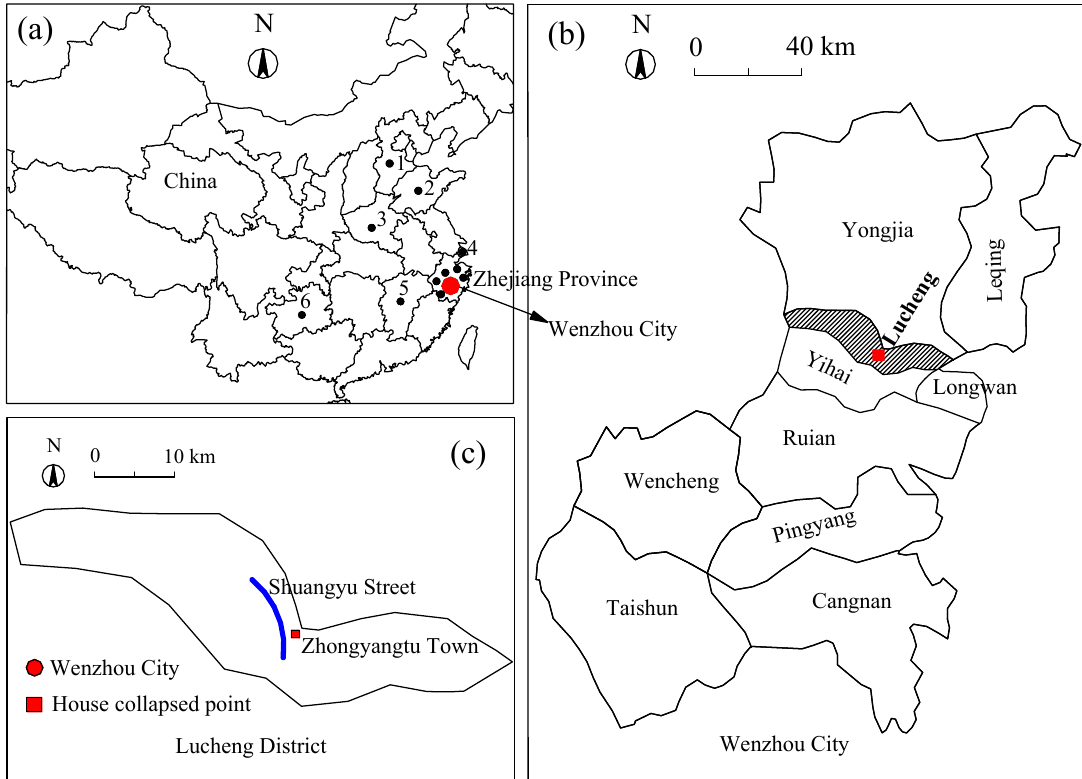
Figure 2. Location of the collapsed site on 10 October 2016: ( a ) collapsed sites (1: Hebei Province; 2: Shandong Province; 3: Henan Province; 4: Shanghai municipality; 5: Jiangxi Province; 6: Guizhou Province); ( b ) administrative zonation map of Wenzhou City; ( c ) detailed location of the site in Zhongyangtu Town, Lucheng District.